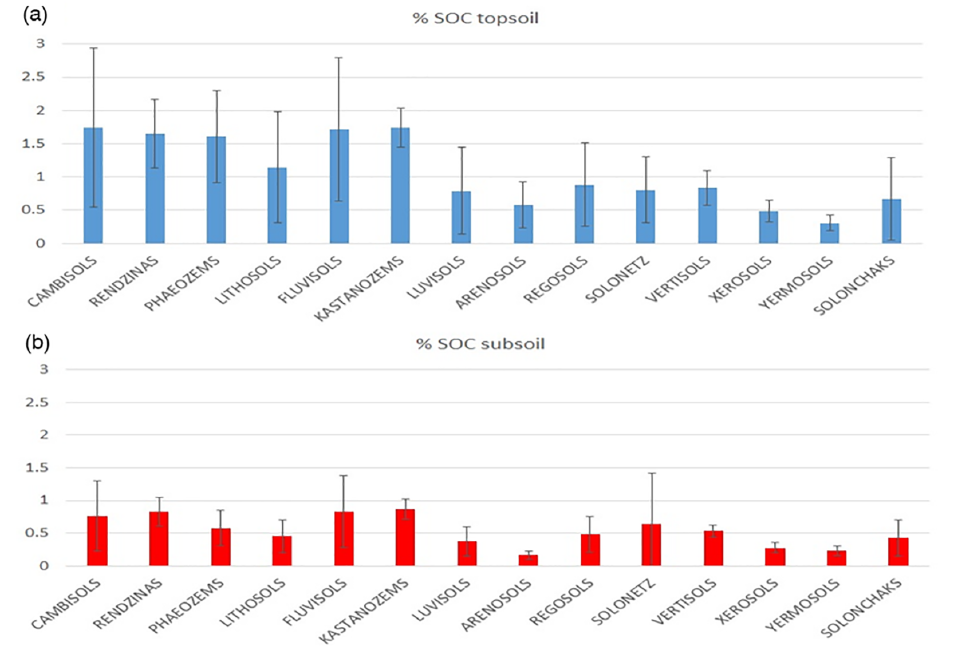
Figure 1. SOC content (%) in topsoil and subsoil in the major soil groups of the NENA region with standard deviation related to soil class. Table 1. Soil inorganic carbon level and the resistance to land degradation in the major soil units of the Near East North Africa region (Source: DSMW, FAO, 2007). Soil classes